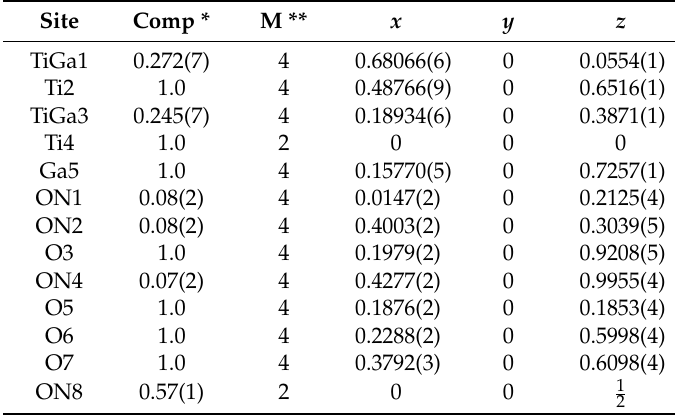
Table A1. Final results from the joint X-ray neutron refinement of the Ga-Ti-O-N